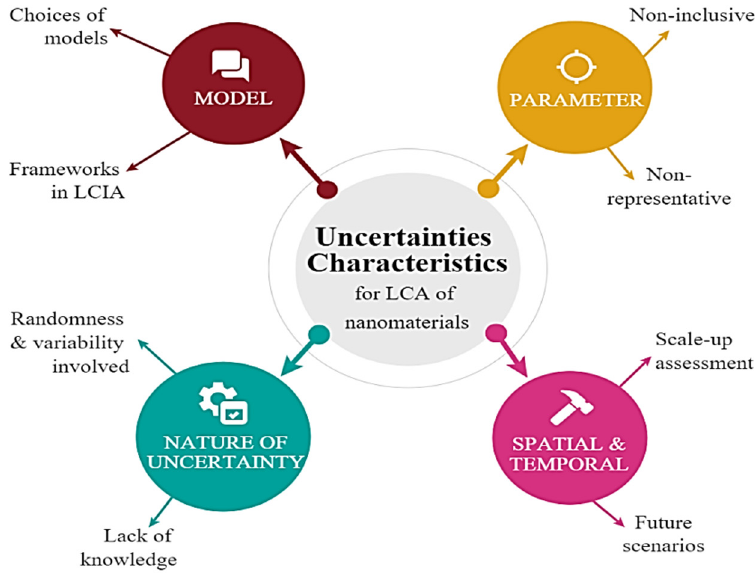
Figure 7. Uncertainties characteristics for LCA of nanomaterials.